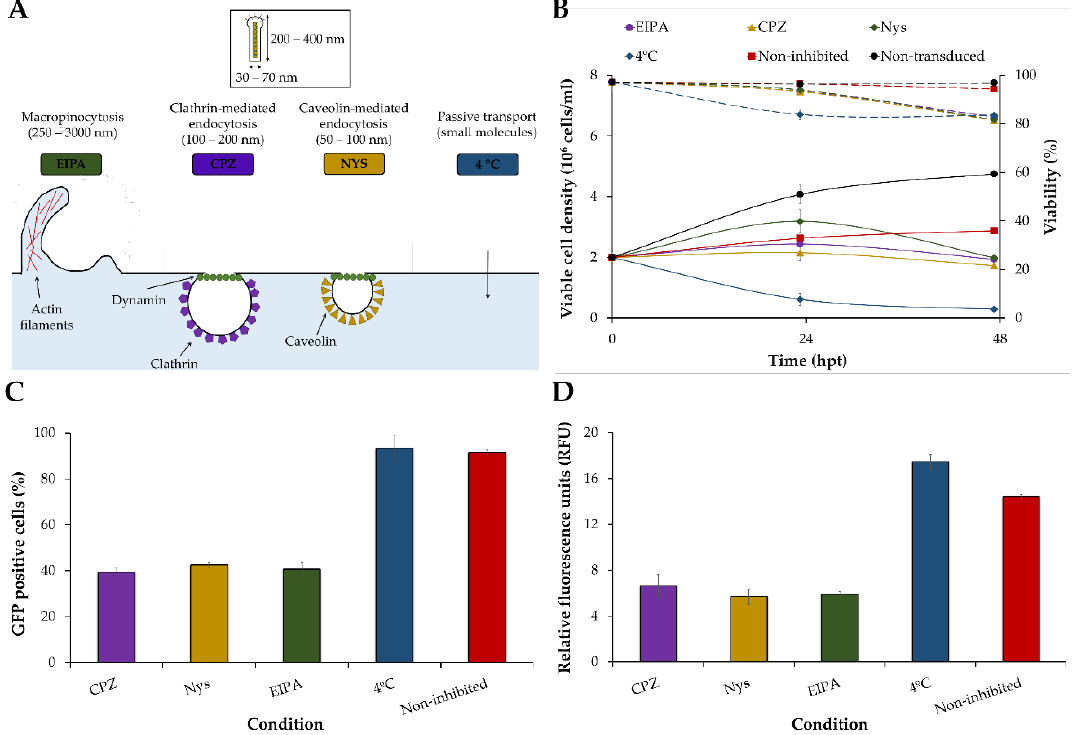
Figure 4. Inhibition of putative BacMam baculovirus endocytic pathways in a drug inhibition assay. ( A ) Schematic of different endocytic pathways. ( B ) Cell growth and viability profiles after drug inhibition of several endocytic pathways. ( C ) HEK293 cell transduction efficiency analyzed by flow cytometry. ( D ) VLP production assessed by spectrofluorometry. Chlorpromazine (CPZ, clathrin-mediated endocytosis), nystatin (Nys, caveolin-mediated endocytosis), N -ethyl- N -isopropyl amiloride (EIPA, macropinocytosis).